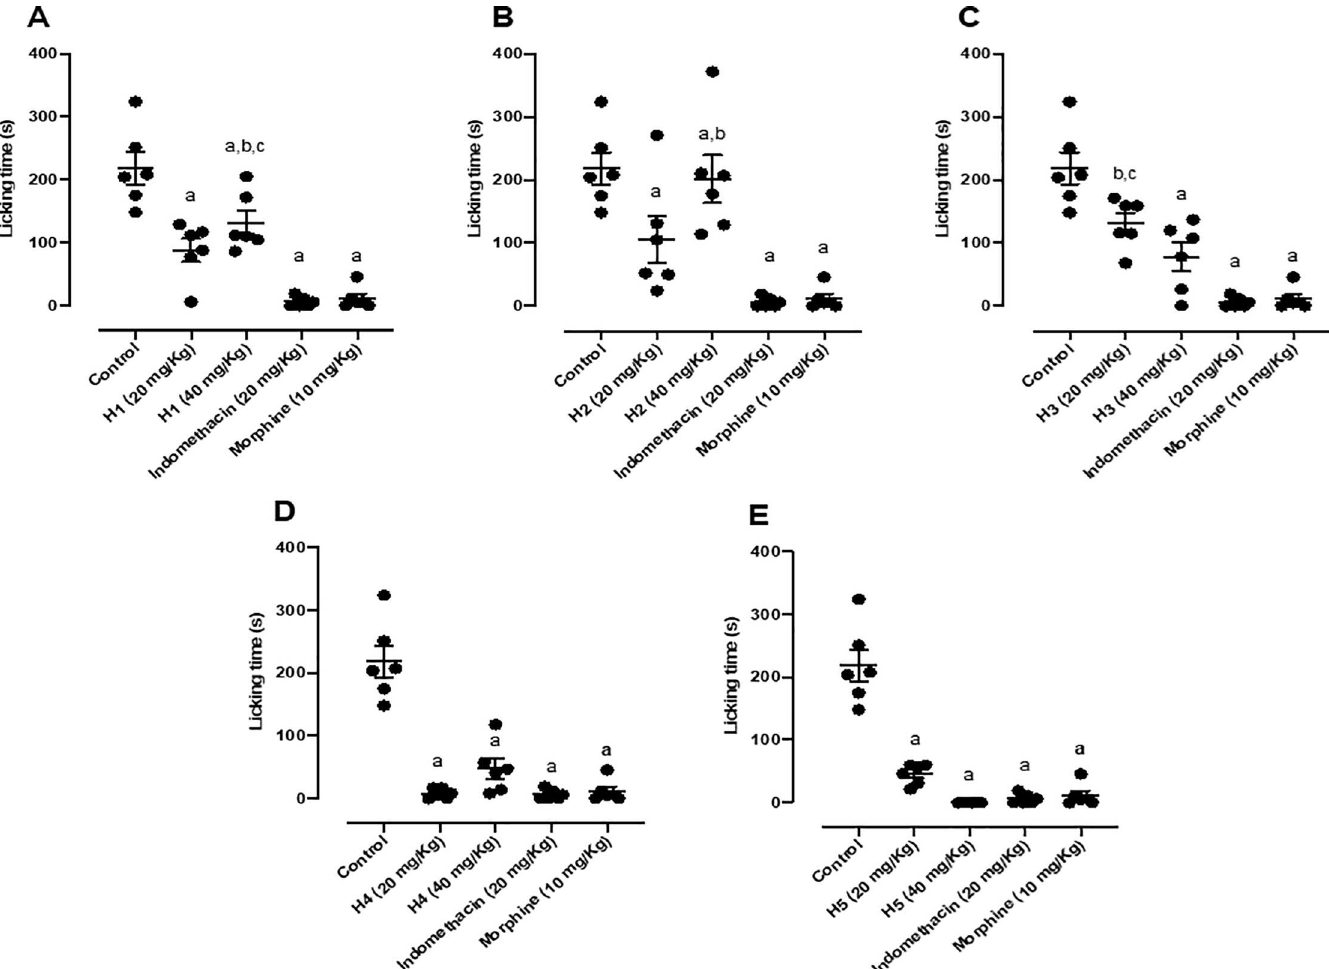
Fig 4. (A) Effect of H1 (20 and 40 mg/kg, p.o.), morphine (10 mg/kg, i.p.) and indomethacin (20 mg/kg, i.p.); (B) Effect of H2 (20 and 40 mg/kg, p.o.), morphine (10 mg/kg, i.p.) and indomethacin (20 mg/kg, i.p.); (C) Effect of H3 (20 and 40 mg/kg, p.o.), morphine (10 mg/kg, i.p.) and indomethacin (20 mg/kg, i.p.); (D) Effect of H4 (20 and 40 mg/kg, p.o.), morphine (10 mg/kg, i.p.) and indomethacin (20 mg/kg, i.p.); (E) Effect of H5 (20 and 40 mg/kg, p.o.), morphine (10 mg/kg, i.p.) and indomethacin (20 mg/kg, i.p.) in the second phase of the formalin-induced nociception test in mice (n = 6, per group). Values are expressed as the mean ± SEM, where a indicates p < 0.05, significantly different from the control group, b indicates p < 0.05 in comparison with indomethacin group and c indicates p < 0.05 in comparison with morphine group, according to ANOVA, followed by Tukey’s